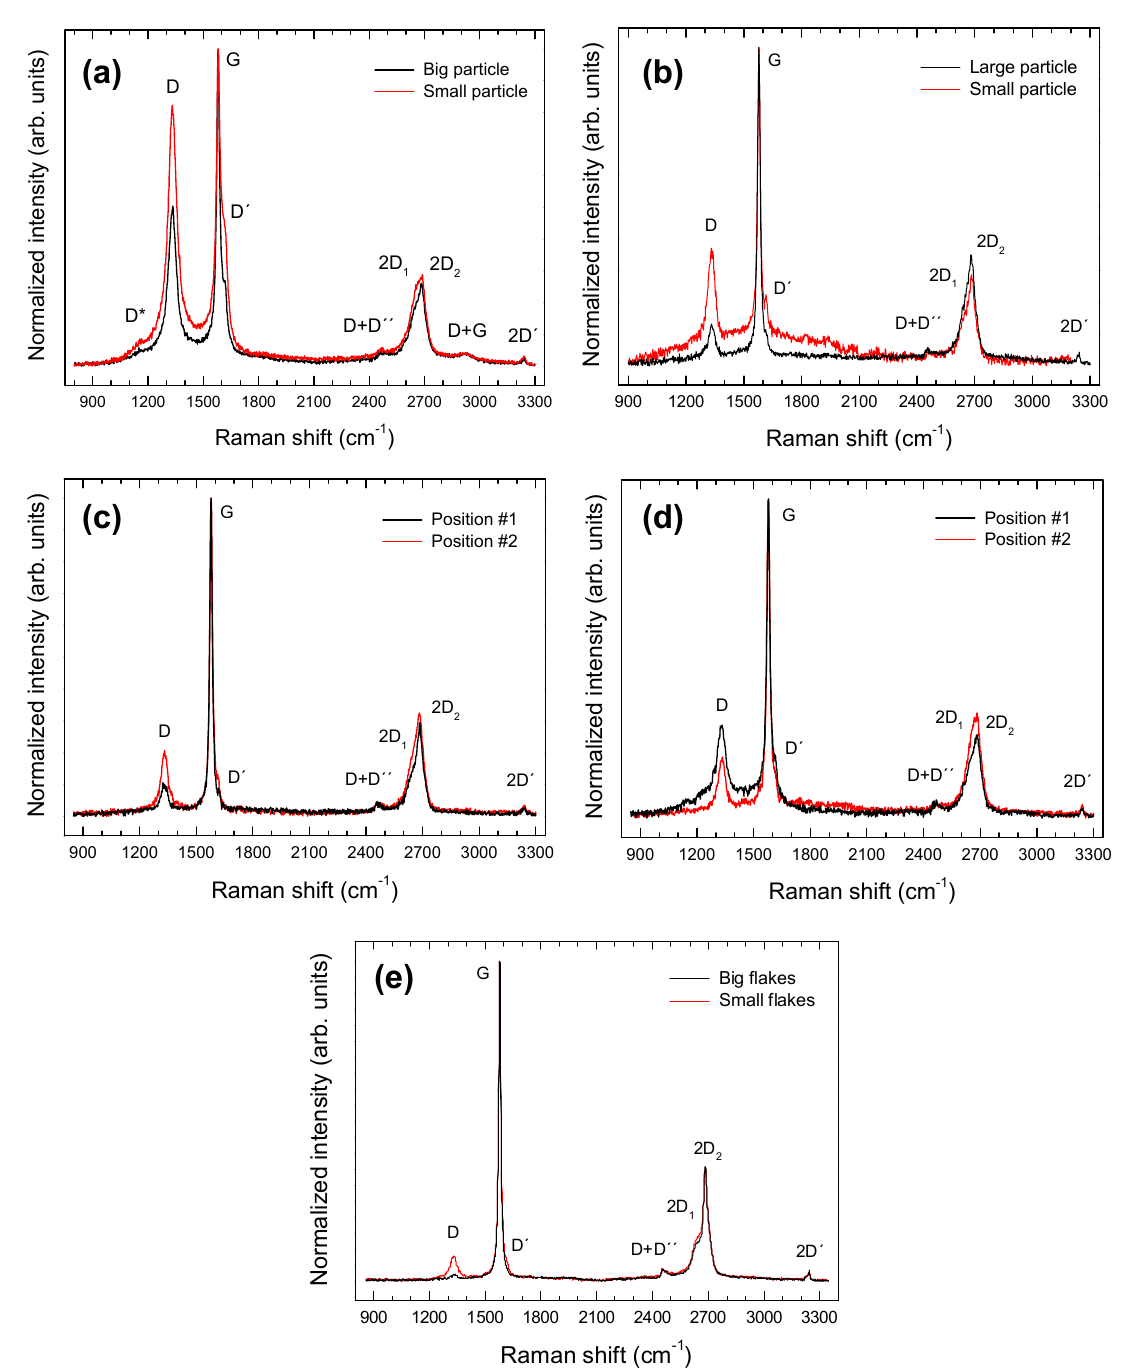
Figure 8. Representative Raman spectra from the ( a ) C-BBM, ( b ) C-SBM, ( c ) C-L 1 BM, ( d ) C-L 2 BM, and ( e ) commercial graphite samples. Table 5. Raman bands positions (cm − 1 ) observed in the investigated samples and their assignments.